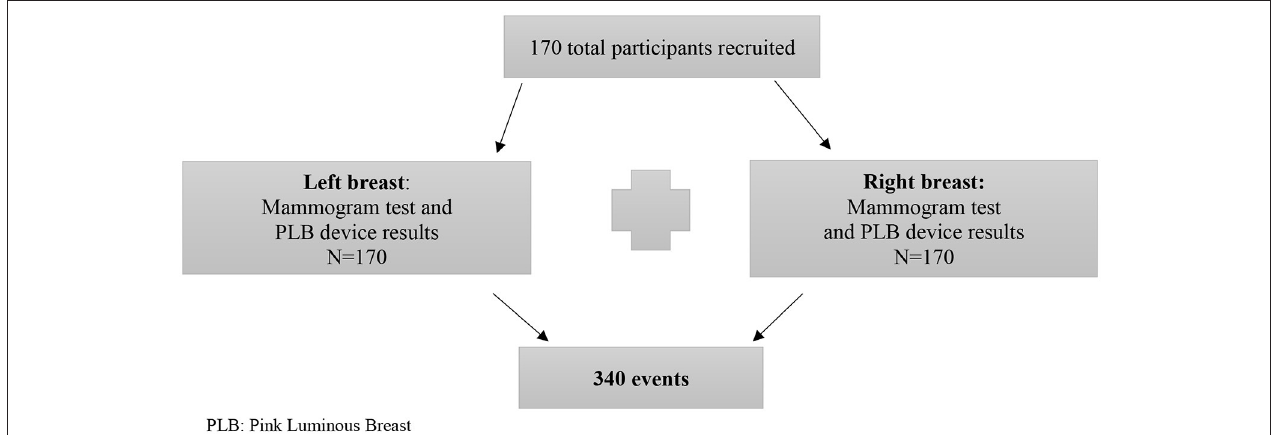
FIGURE 1 | Sample size of the recruited participants and resulting individual events. PLB, Pink Luminous